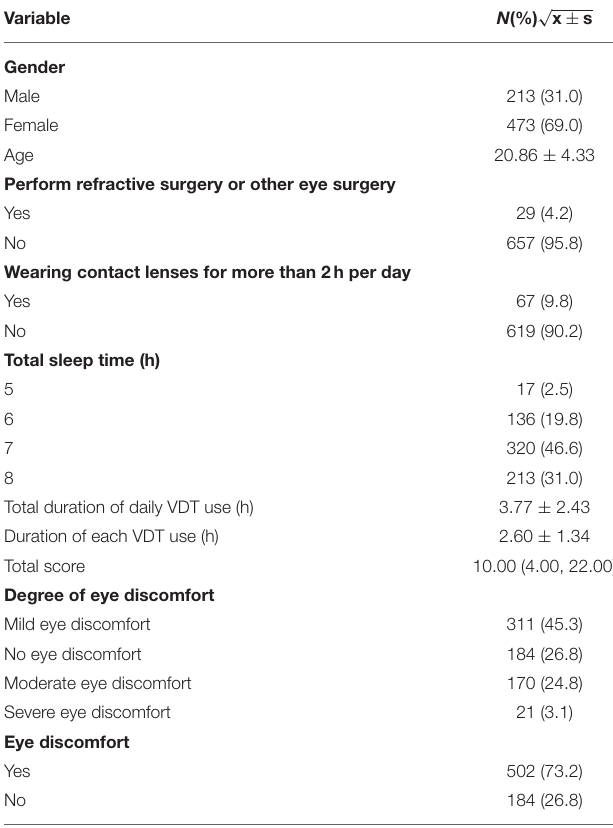
TABLE 1 | Description of the general clinical characteristics of the study subjects.